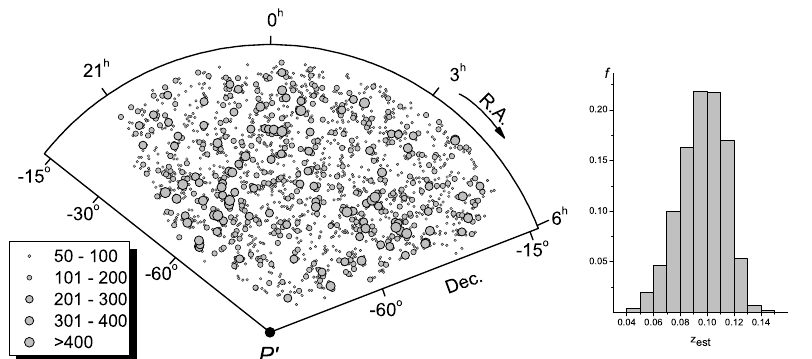
Fig. 1. The left panel shows the distribution of galaxy clusters on the celestial sphere from the input catalogue, where symbol size correlates with the galaxy cluster richness. The right panel is a histogram of estimated redshifts for the input galaxy